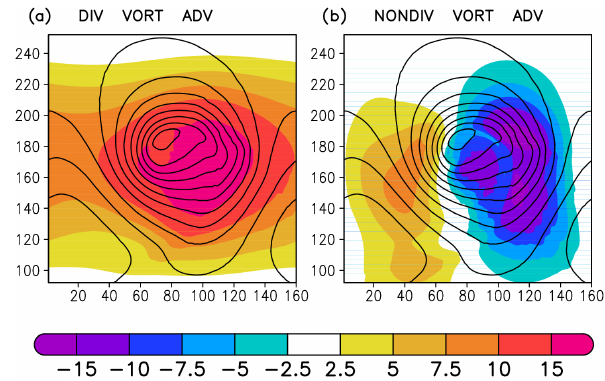
Figure 10. Height tendency associated with vorticity advection by the (a) divergent and (b) nondivergent winds at 900hPa at time 118h. Unit is mh − 1